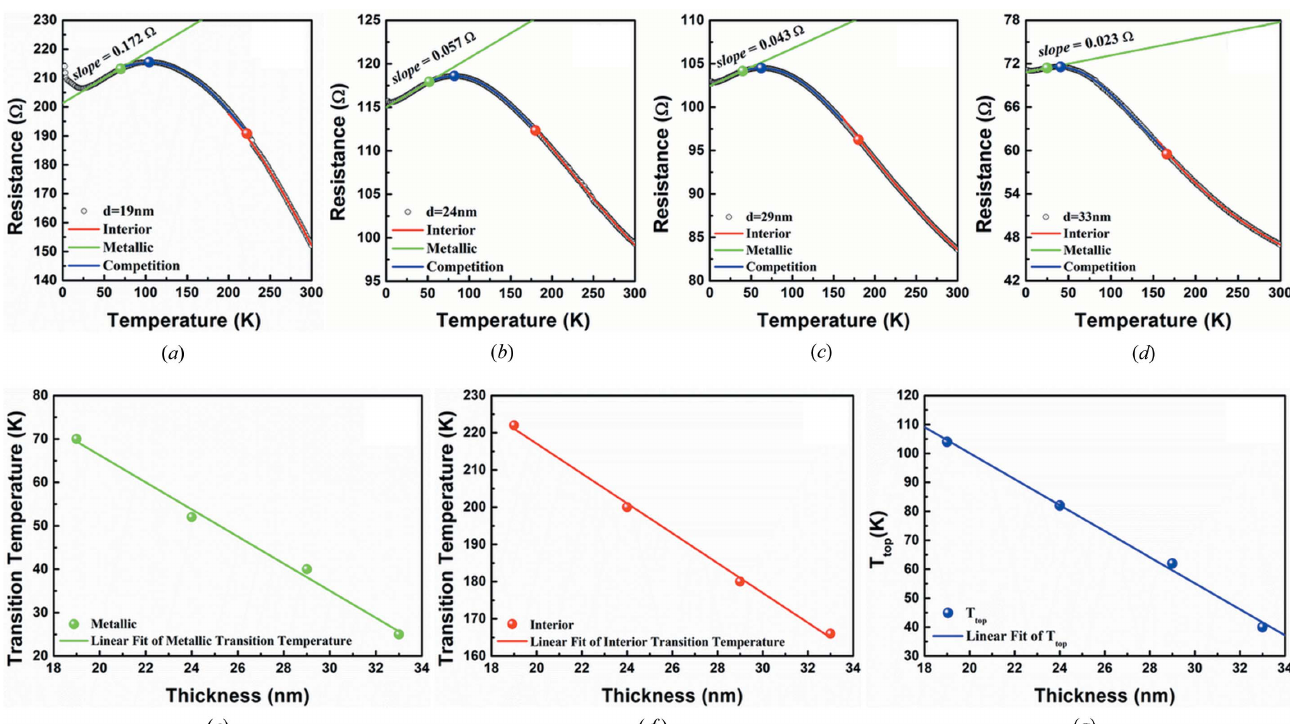
Figure 10 The temperature dependence for resistance of Bi thin films at thicknesses of ( a ) 19 nm, ( b ) 24 nm, ( c ) 29 nm and ( d ) 33 nm. The red line represents the e- index fitting, the green line represents the line fitting and the blue line represents two-transport channels fitting. Furthermore, ( e )–( g ) are the feature transition temperature points extracted from ( a )–( d ) and represent transition temperature as a function of sample thickness. ( e ) The deviation metal- surface-states point (green solid symbols), ( f ) the deviation semiconductor-bulk-states point (red solid symbols) and ( g ) the metal-surface-states transition temperature T top corresponding to the maximum resistance in the metal and bulk states